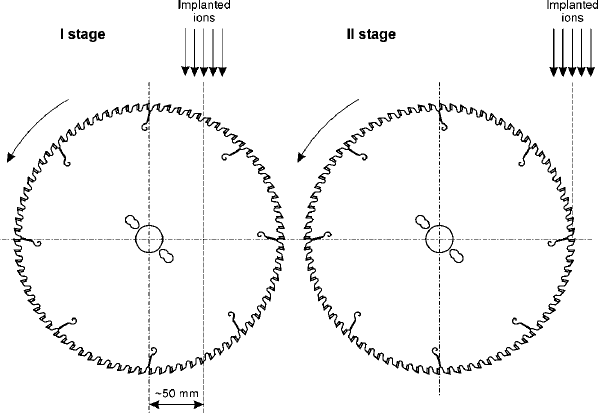
Figure 3. Scheme of the ion implantation of circular saw blades used for investigations.